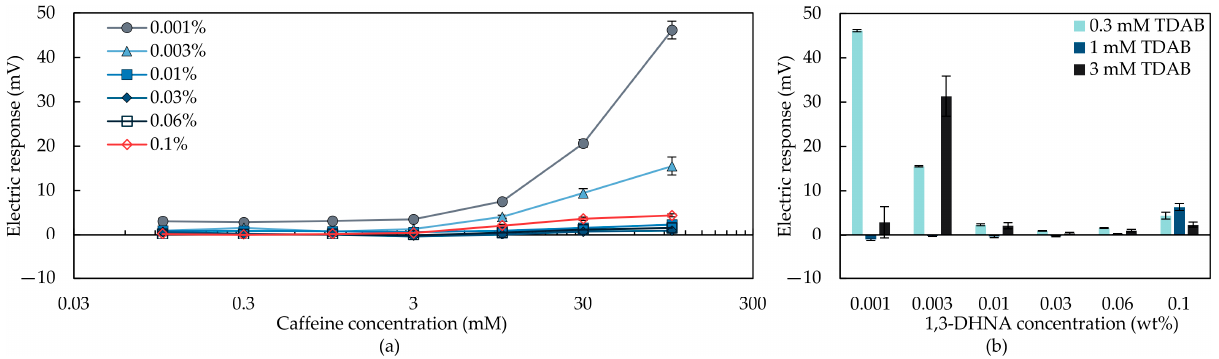
Figure 7. Response to caffeine in sample solutions measured using taste sensors with membrane modified with 1,3-DHNA: ( a ) Concentration of caffeine determined using the taste sensors with 0.3 mM TDAB membrane modified with different concentrations of 1,3-DHNA as a function of the response value; ( b ) electric response to 100 mM caffeine when using lipid/polymer membrane modified with different concentrations of 1,3-DHNA. The error bar indicates the SD of data, n = 4 (electrode) × 4 (rotation) = 16 values.